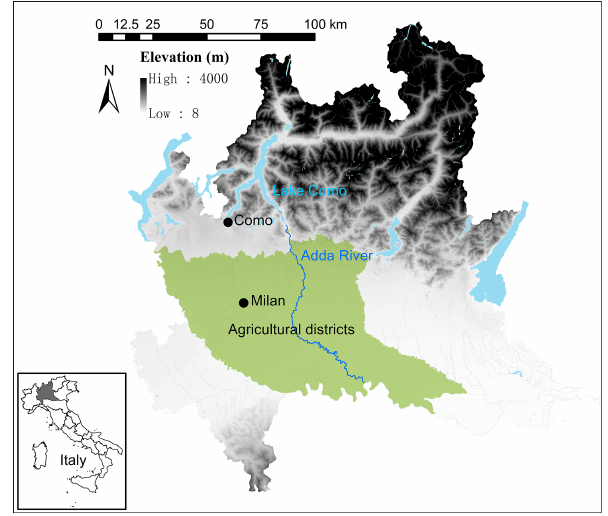
Figure 1. Map of the Lake Como system in the Lombardy re- gion, northern Italy. The map was generated via QGIS using layers from the geoportal of Regione Lombardia (http://www.geoportale. regione.lombardia.it/, last access: July